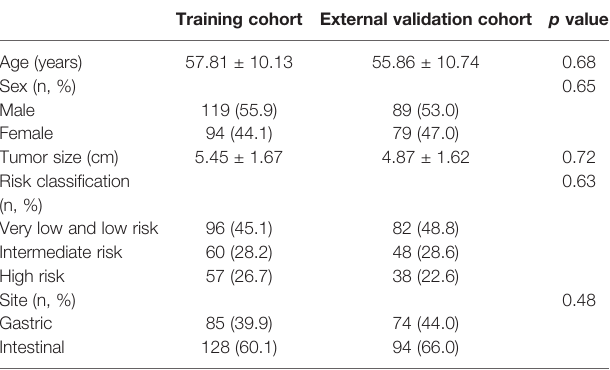
TABLE 2 | Patient characteristics in the training and external validation